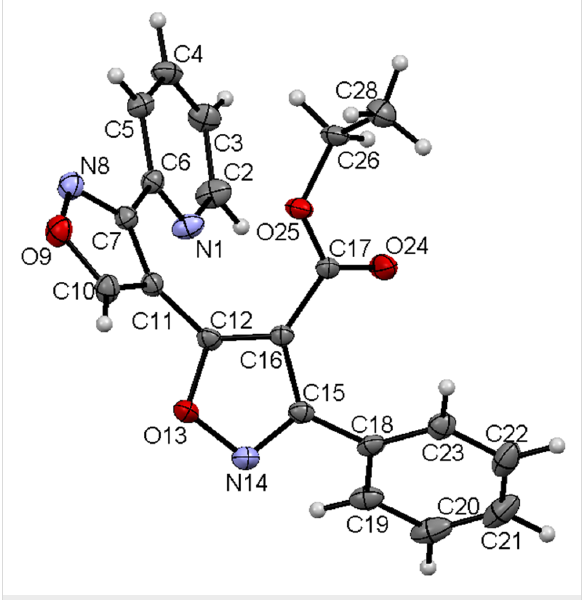
Figure 4: Isoxazolylisoxazole 4p according to XRD data with thermal ellipsoids of 50% probability level.